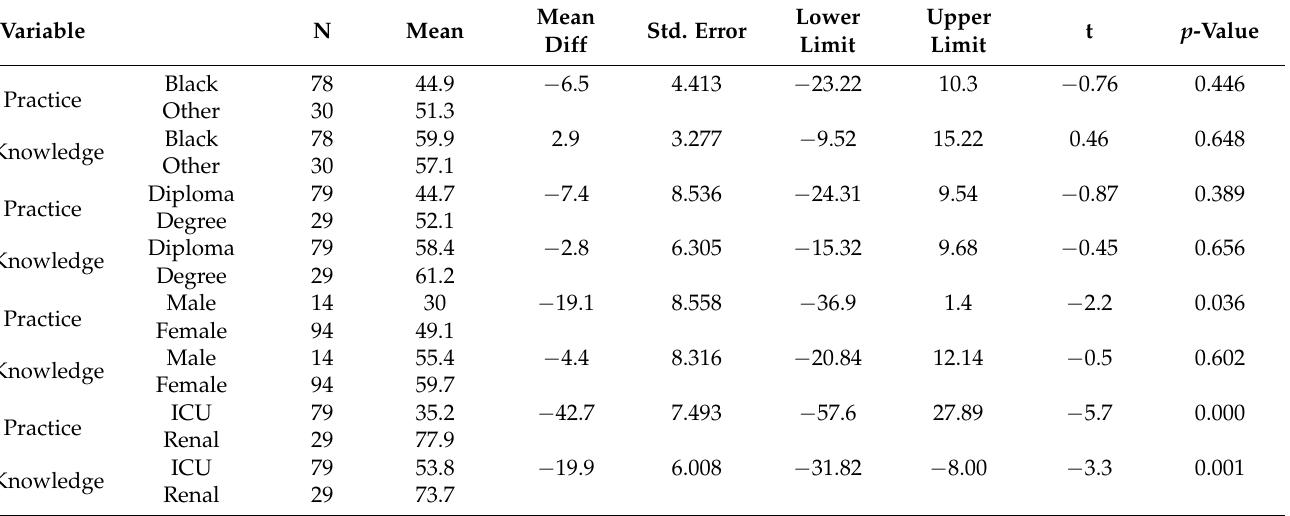
Table 3. Comparisons of organ donation practice and knowledge by unit, race, gender, and